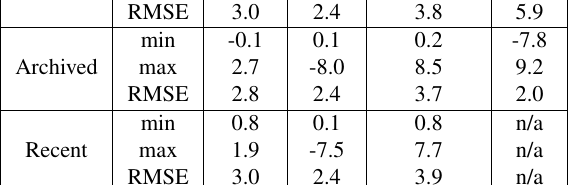
Table 1: The CPs errors. Expected error Expected error elev. error